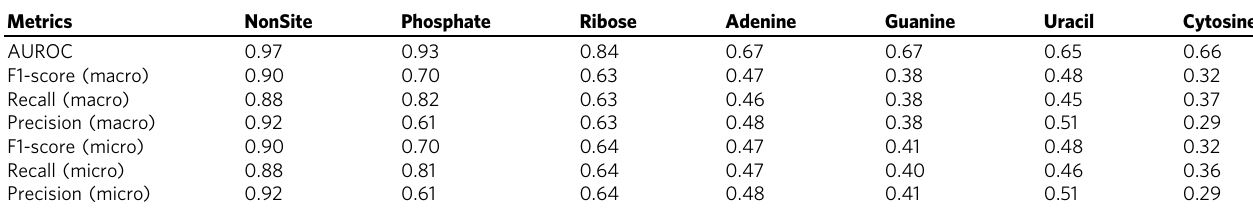
Table 1 Statistics of performance in cross validation of the non-redundant dataset from PDB Metrics